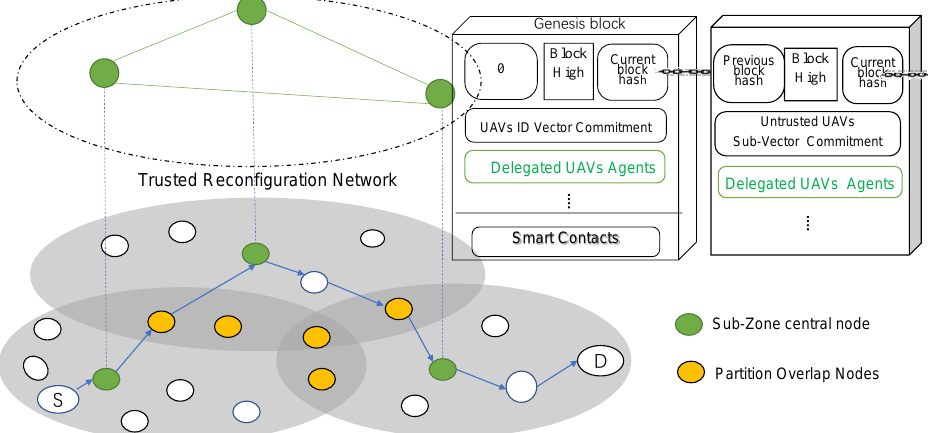
Figure 1. Blockchain-assisted reconfigured trusted network system model for